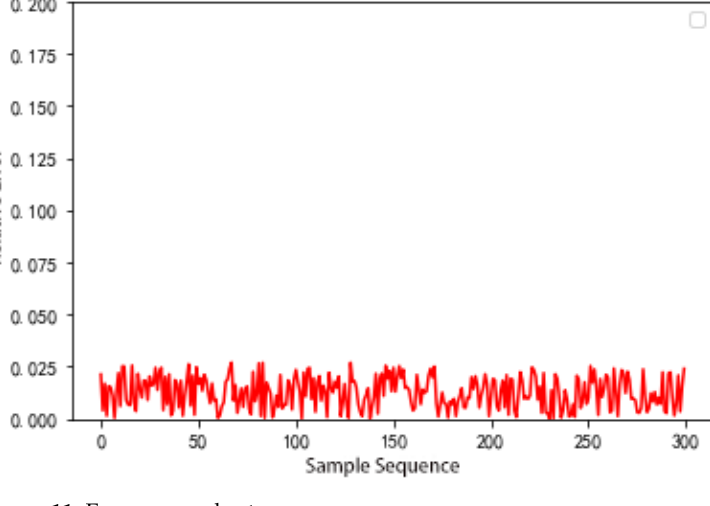
Figure 11. Error curve chart.